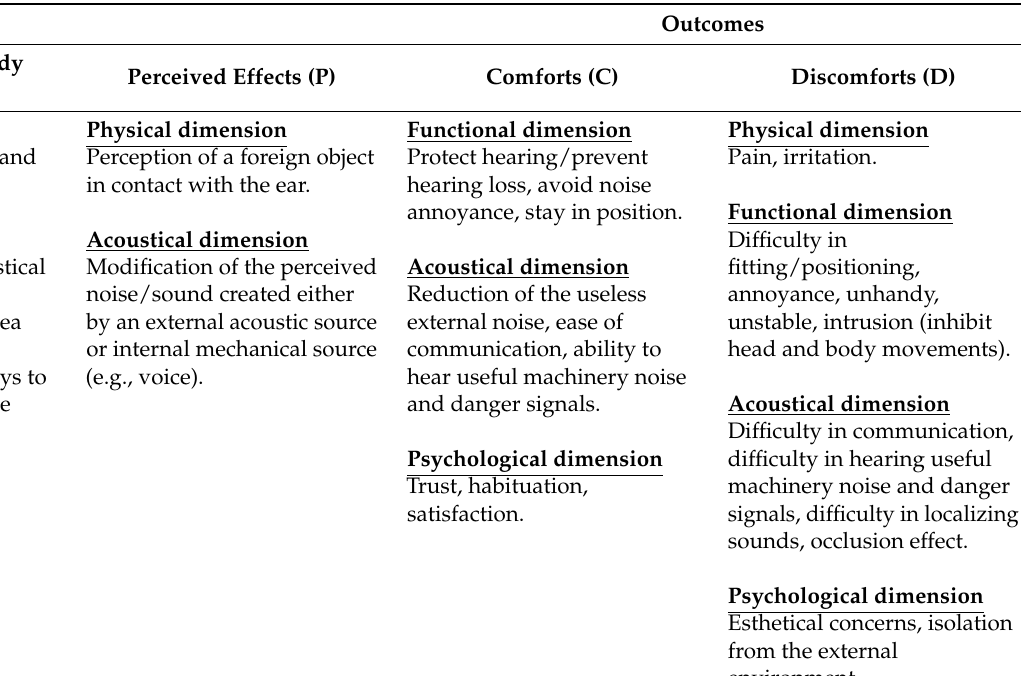
Table 3. Phases and outcomes of the proposed HPD comfort